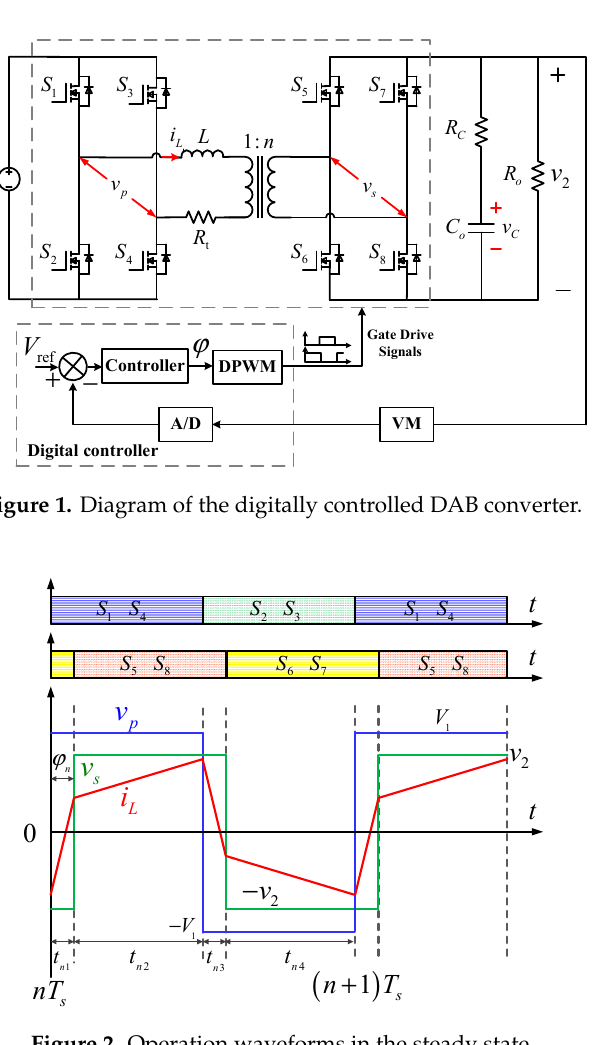
Figure 2. Operation waveforms in the steady state.